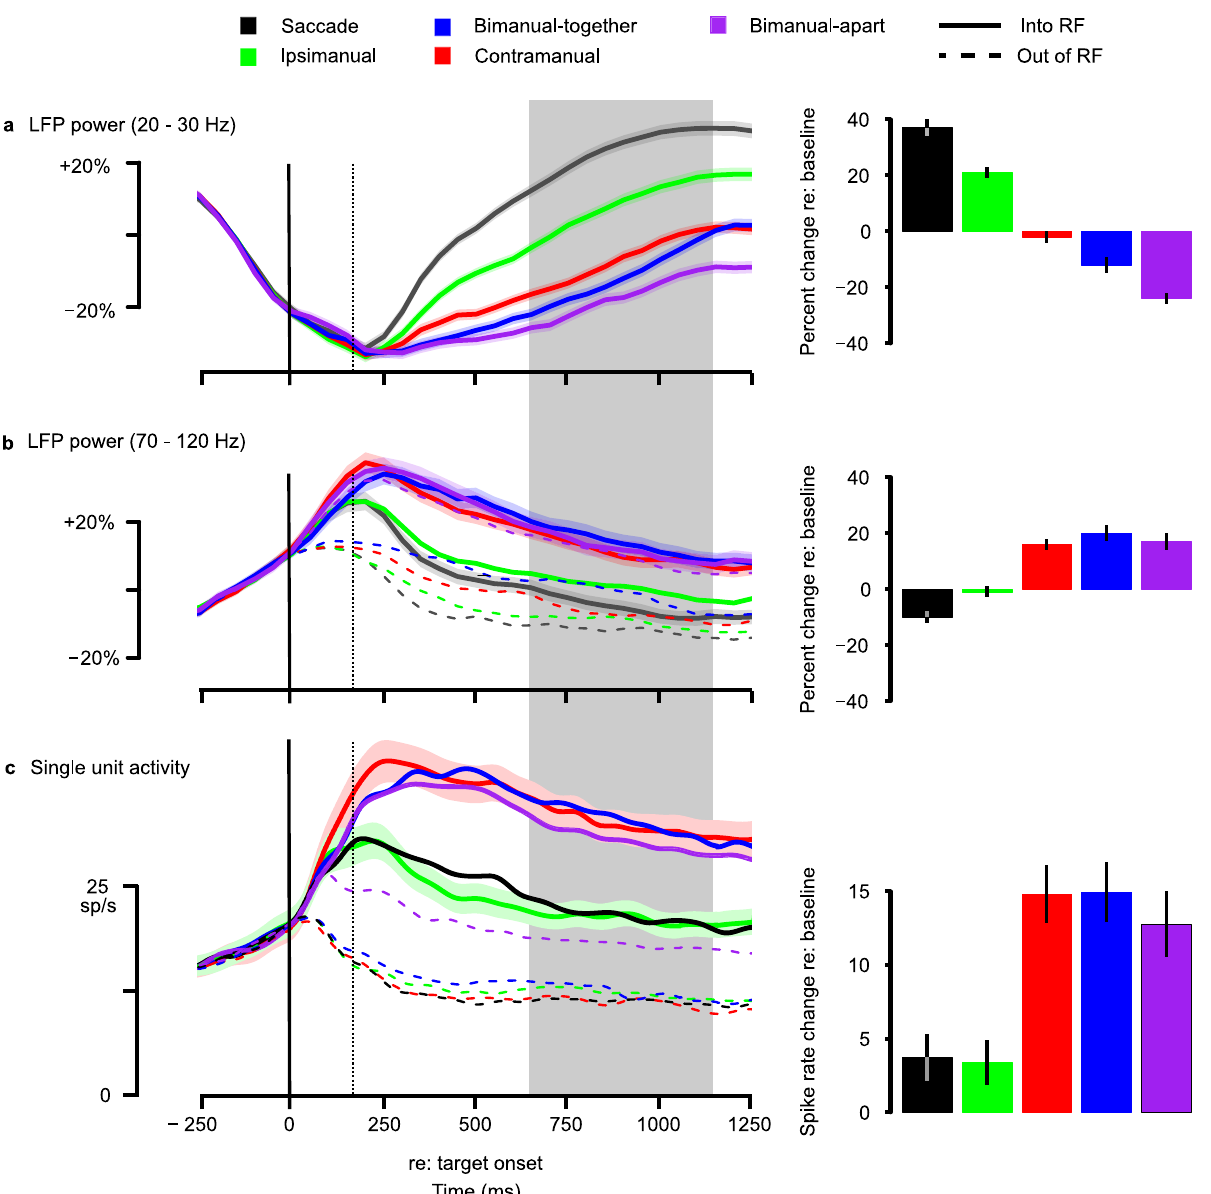
Fig. 3 A comparison of neural activity during 5 movement conditions. Data on the left are aligned to target onset (solid vertical line) and truncated at the time of the earliest cue to initiate movement. Data on the right show the mean activity for preferred direction movements, relative to baseline, in the interval from 650 to 1150 ms (gray rectangle). a Beta-band LFP power (20 – 30 Hz) contains information about movement type. Power is computed in ±200 ms intervals every 100 ms. Colored shading indicates ±1 s.e.m. Responses to preferred and null directions showed no difference and so are merged across n = 312 sites. b Gamma-band LFP power (70 – 120 Hz) is similar but not identical to unit activity and unlike the beta band contains little additional information. (See text for additional detail.) Format as in a except that preferred and null directions are shown separately. Power is computed in ±100 ms intervals every 50 ms. c Single-unit activity is high when the animal prepares a contramanual reach in the preferred direction, whether alone (contramanual, solid red line), with an ipsimanual reach in the same direction (bimanual-together, blue), or with an ipsimanual reach in the opposite direction (bimanual-apart, purple). Firing is intermediate for preferred direction saccades and for preferred direction ipsimanual reaches (solid green and black), and for bimanual reaches in which the ipsilateral arm moves in the preferred direction and the contralateral arm moves out (bimanual-apart, dashed purple). (Bimanual-apart reaches are labeled based on the direction of the contralateral arm.) Activity is low for single-target movements in the null direction (dashed lines) during the delay period, independent of the movement type. Note that the divergence of fi ring rate associated with movement type (dotted vertical line) occurs ~100 ms sooner than the divergence in beta LFP power associated with movement type. Data from n = 113 single units. Colored shading indicates ±1 s.e.m. Source data are provided as a Source Data fi A second regime occurs at lower frequencies, from about 16 to point of minimum power occurs at a low frequency for saccades 32 Hz. Here LFP power depends strongly on both movement type ( ≤ 8 Hz), at an intermediate frequency for ipsimanual reaches and frequency, but only weakly on the direction. Responses (~8 – 16 Hz), and at still higher frequencies for contramanual, are not clustered but instead are ordered by movement type. The bimanual-together, and bimanual-apart reaches (12 – 20 Hz).